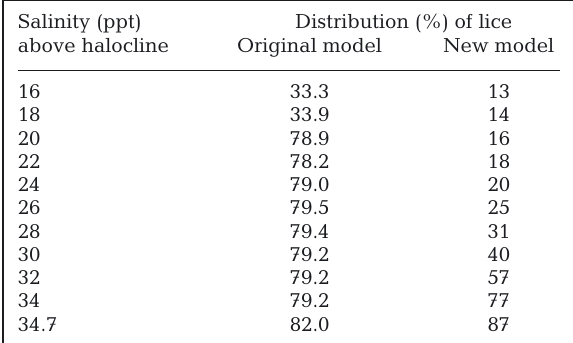
(Table 1). Distributions of modelled nauplii and cope- podids under different salinity step gradients are given in Figs. S1 & S2 in the Supplement at www.int-